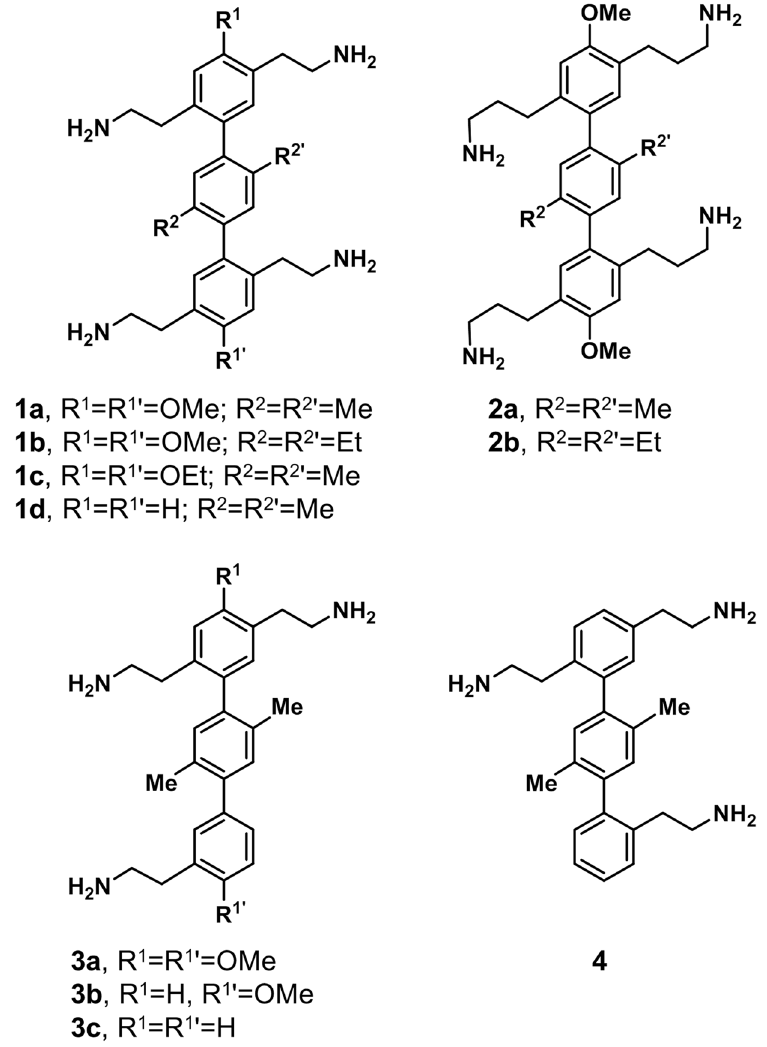
Figure 2. Chemical structure of 1,4-substituted p -terphenyl compounds analysed in this